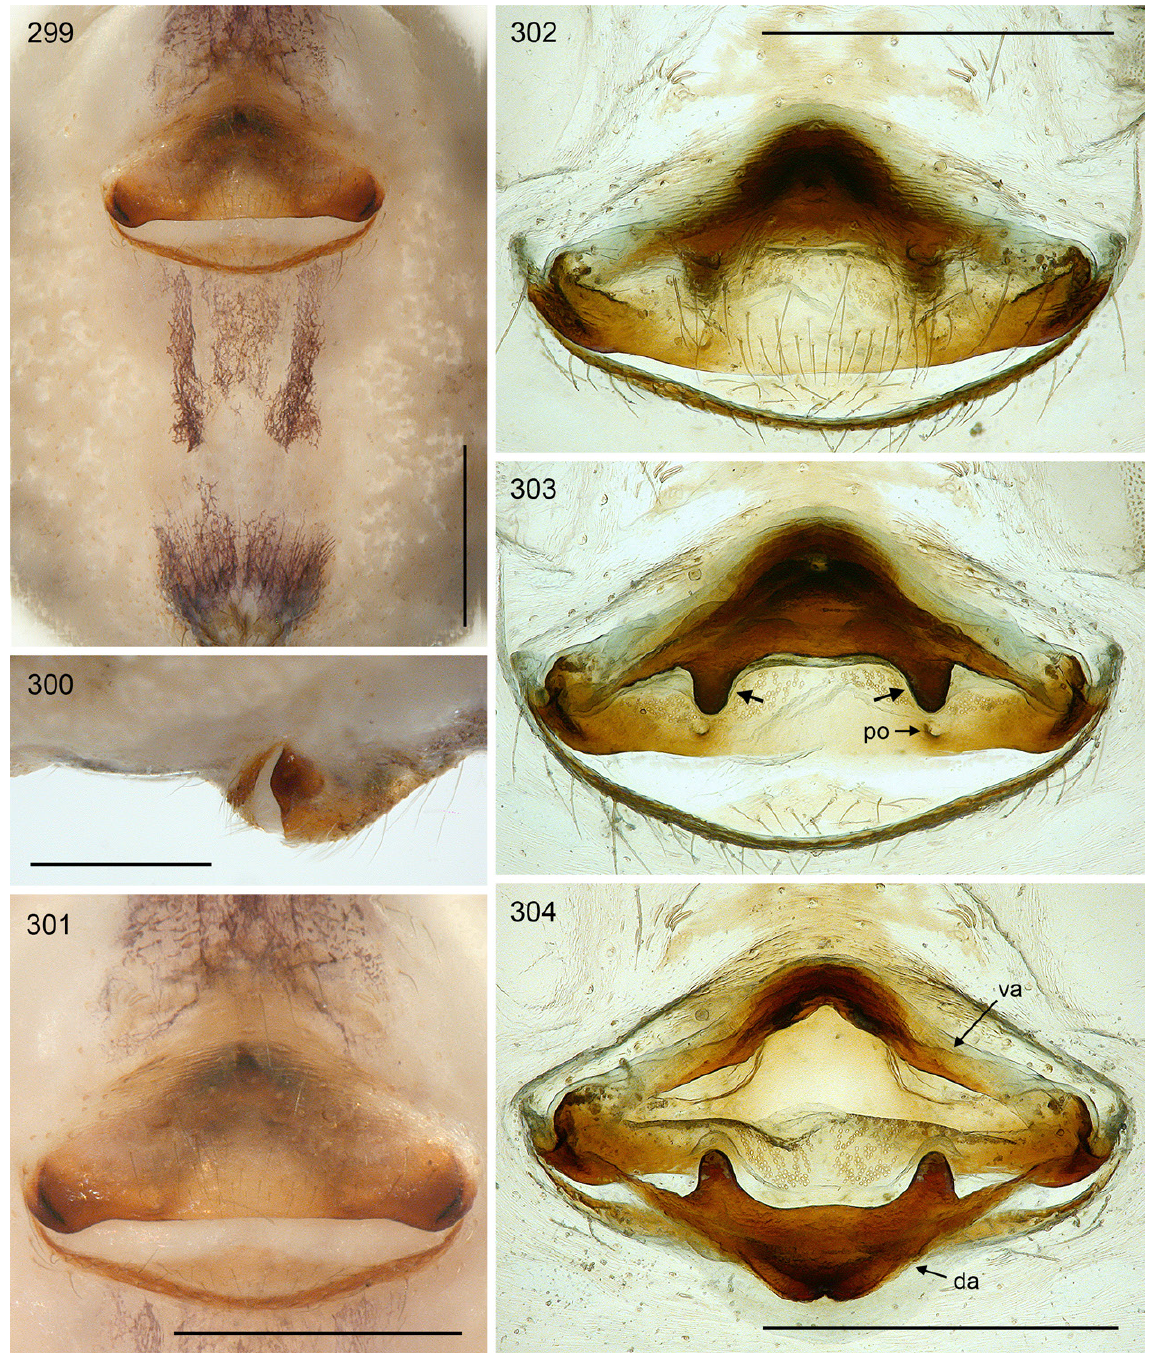
Figs 299–304. Maghreba aurouxi (Barrientos, 2019) gen. nov.; female from Morocco, SE of Zebzat (ZFMK Ar 22386). 299 . Abdomen, ventral view. 300–301 . Epigynum, lateral and ventral views. 302– 304 . Cleared female genitalia, ventral view, regular dorsal view, and dorsal view with dorsal arc tilted backwards; arrows: posterior processes on dorsal arc. Abbreviations: da = dorsal arc; po = pocket; va = ventral arc. Scale bars = 0.5